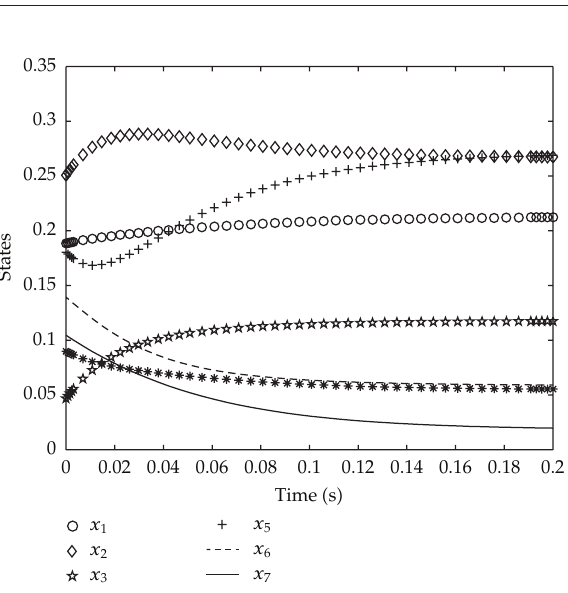
Figure 7: The plots of the seven states in Case 3 (cid:3) An isothermal CSTR problem (cid:4) .